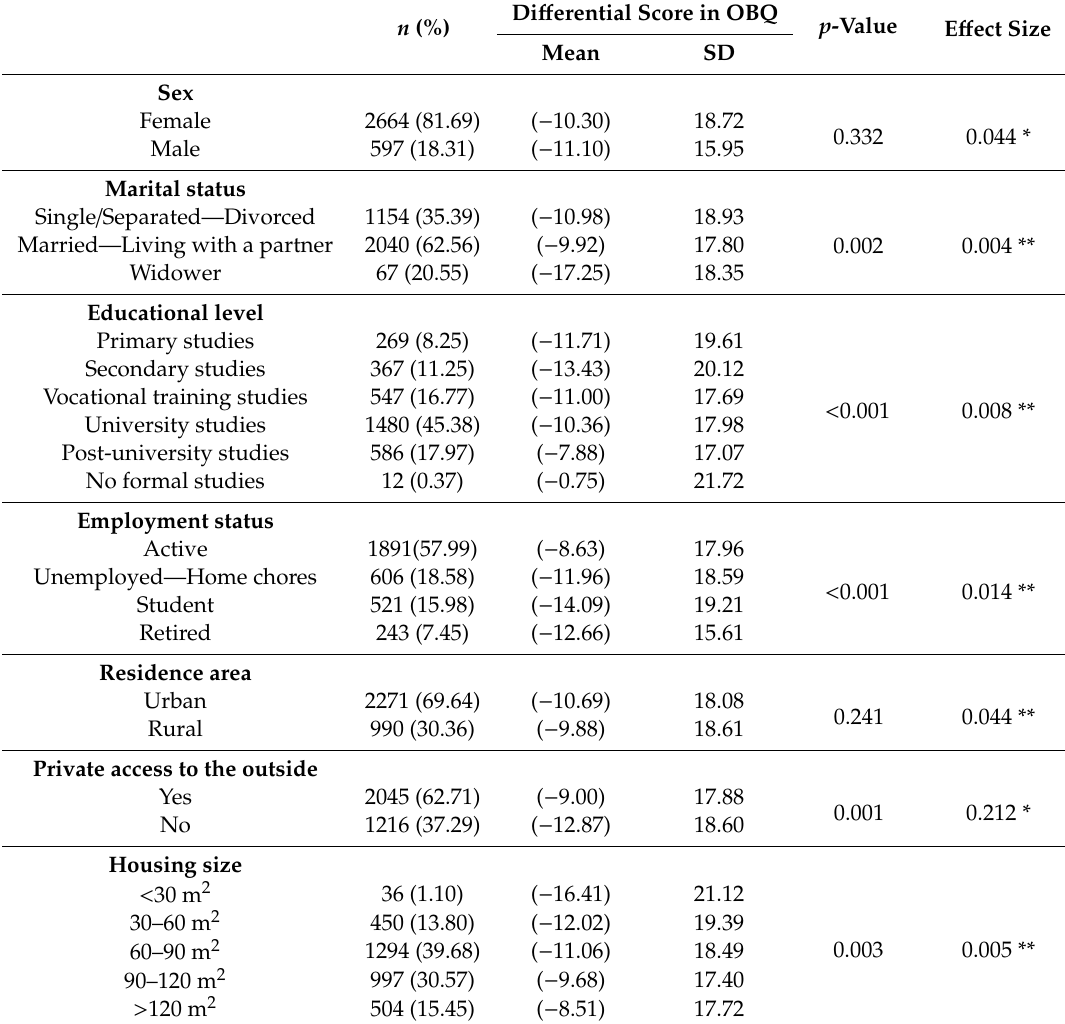
Table 1. Comparison of di ff erential scores in the OBQ according to sociodemographic variables.